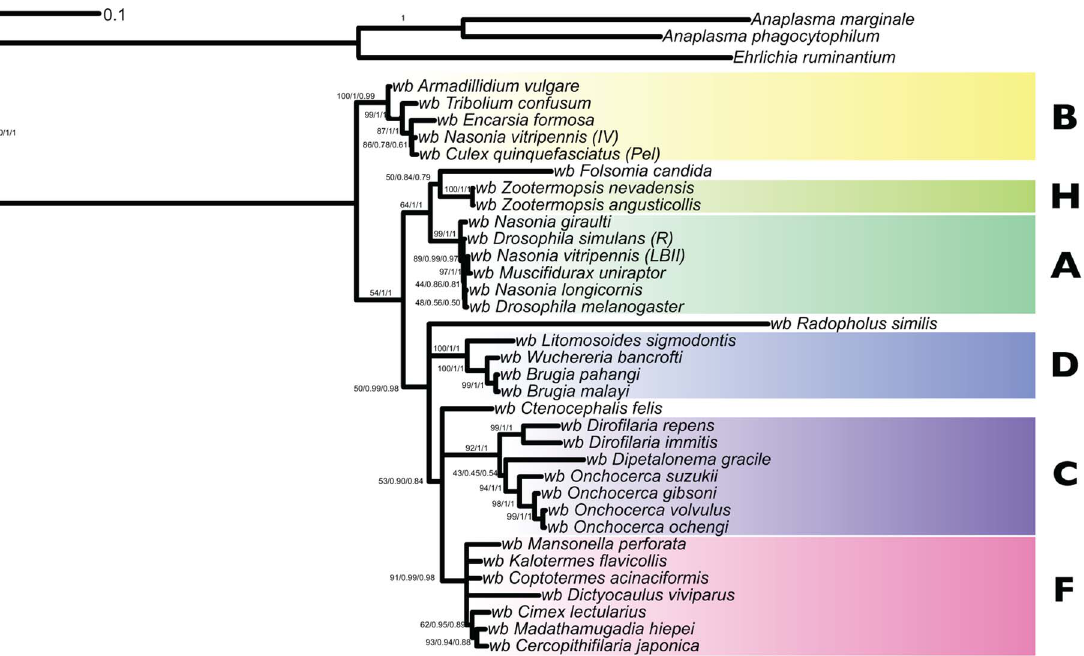
Figure 5. Analysis of the phylogenetic relationships of the Wolbachia nuclear insertions in the Dictyocaulusviviparus genome. Phylogenetic tree inferred from 16S rDNA, groEL, ftsZ, dnaA and coxA loci with maximum likelihood (RAxML) and Bayesian (MrBayes, PhyloBayes) inference. Branch support is reported as (RaxML/MrBayes/PhyloBayes). Strains representing Wolbachia supergroups A, B, C, D, F and H are indicated.